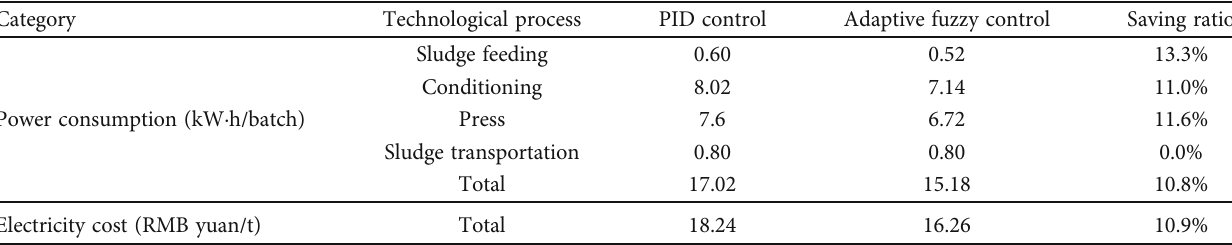
Table 1: Comparative analysis of power